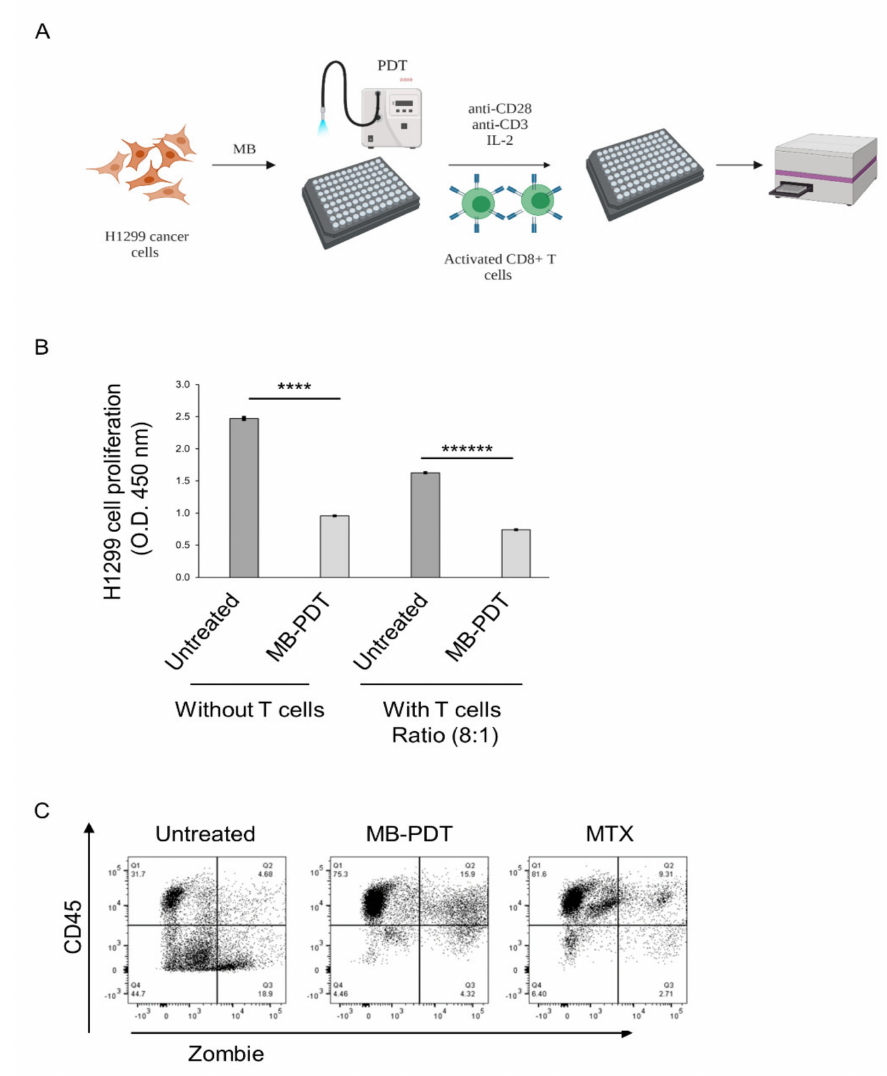
Figure 4. MB-PDT promotes the cytotoxic activity of CD8+ T cells followed by an inhibition of proliferation of human lung cancer cells. ( A ) Schematic experimental protocol of co-culture killing assays. ( B ) H1299 cells proliferation in a co-culture was measured 24 h post-treatment. Then activated CD8 + T cells (IL-2 1000 ng/mL) were co-cultured with H1299 cells for 24 h at a ratio of 8:1. The proliferation of H1299 cells in co-culture was analyzed by WST-1 assay. The experiment was carried out in triplicate, and the results presented as means ± SD. Significance determined by two tailed Student’s t -test. **** p = 0.0002, ****** p = 0.000008. ( C ) Flow cytometry confirmed that MB-PDT- treated H1299 cells are killed more efficiently by activated CD8+ T cells in a co-culture for 48 h. A ratio of T cells vs. cancer cells is 8:1. Numbers indicate percentage of specific labelled